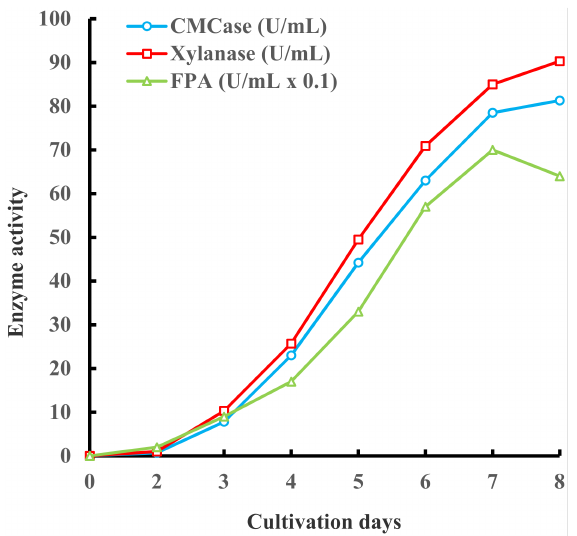
Figure 2. Kinetics of CMCase, xylanase, and FPA accumulation in I. lacteus cultivation in fermenter.